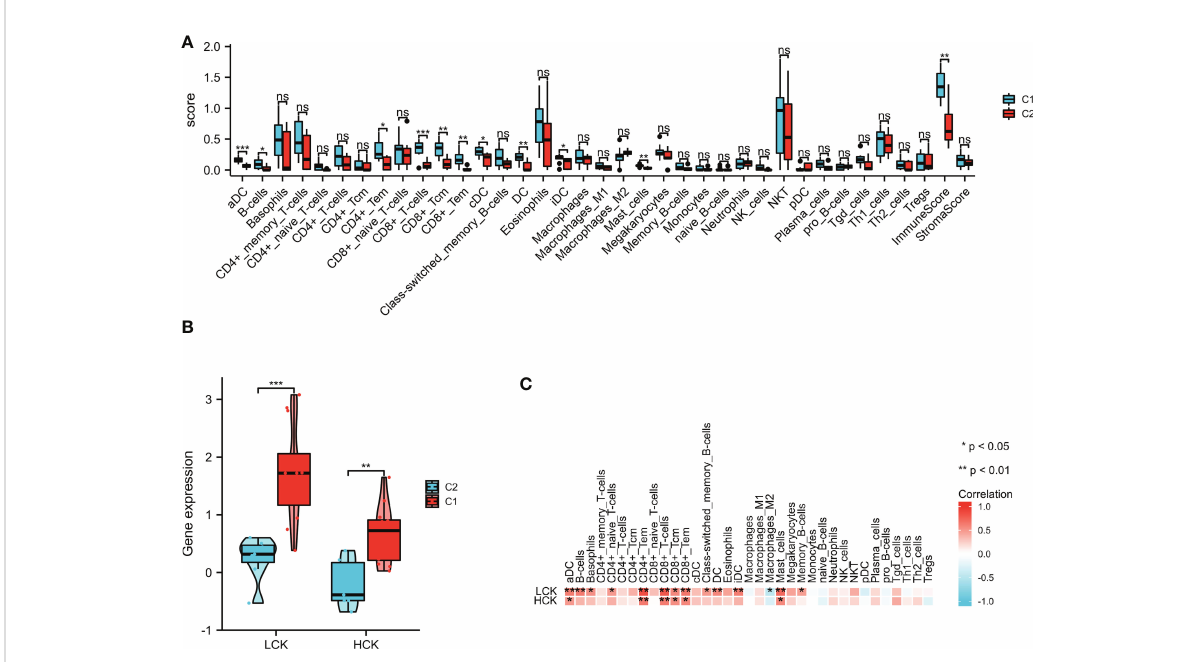
FIGURE 11 xCell algorithm was used to perform immune cell in fi ltration analysis. (A) The landscape of the 35 types of immune cells between C1 and C2 subgroups. (B) LCK and HCK gene expression between C1 and C2 subgroups. (C) Correlation analysis between the core genes and 35 immune cell in fi ltration levels. *p < 0.05; **p < 0.01; ***p < 0.001; ns, no statistical